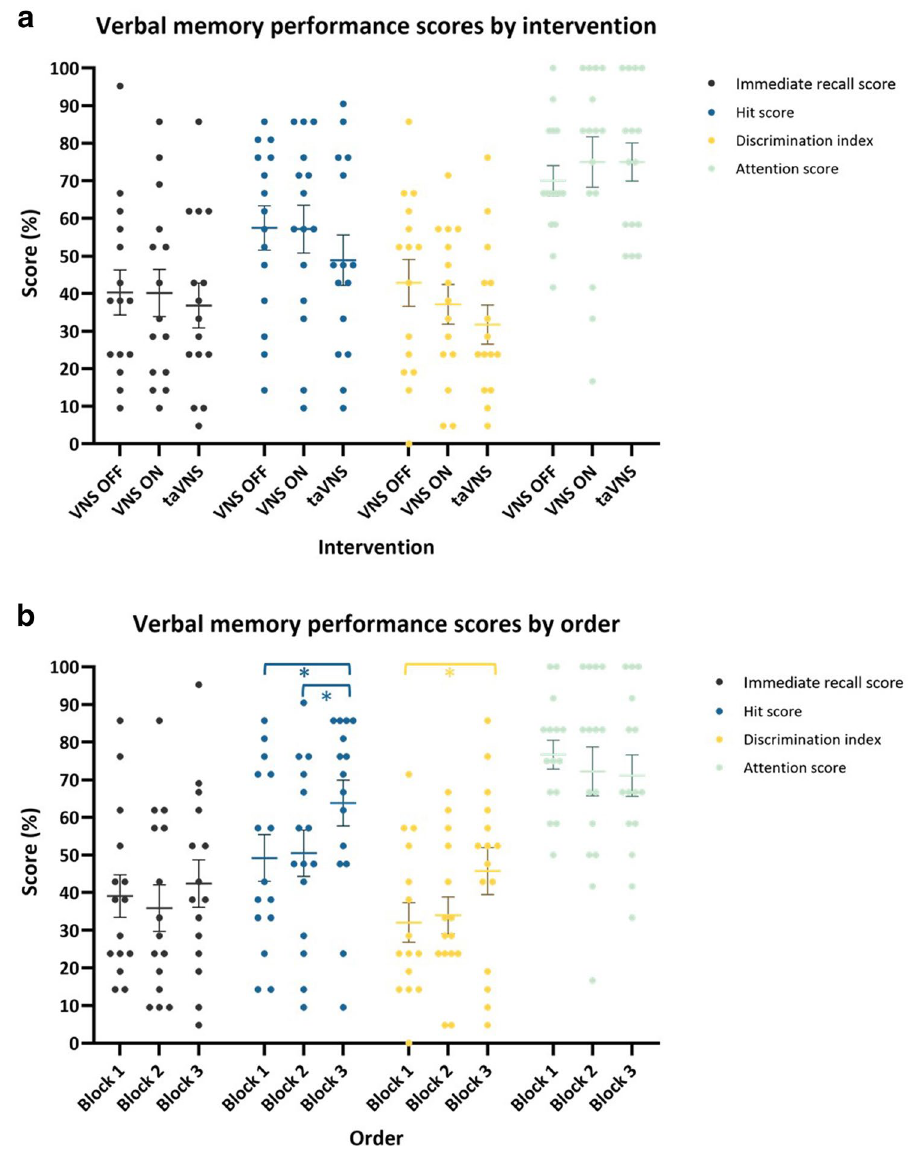
Figure 2. Verbal memory performance by intervention ( a ) and order ( b ) in session 1. ( a ) There was no effect of intervention on all verbal memory performance scores. A trend was seen for lower hit and discrimination index scores after taVNS. ( b ) A significant effect of order was seen for hit scores ( p = 0.001) and discrimination index ( p = 0.022).Pairwise comparison demonstrated significantly higher hit scores in block 3 compared to block 2 and block 1 and a significantly higher discrimination index in block 3 compared to block 1. Error bars indicate group mean ± standard error (SE). Significant findings are indicated by an